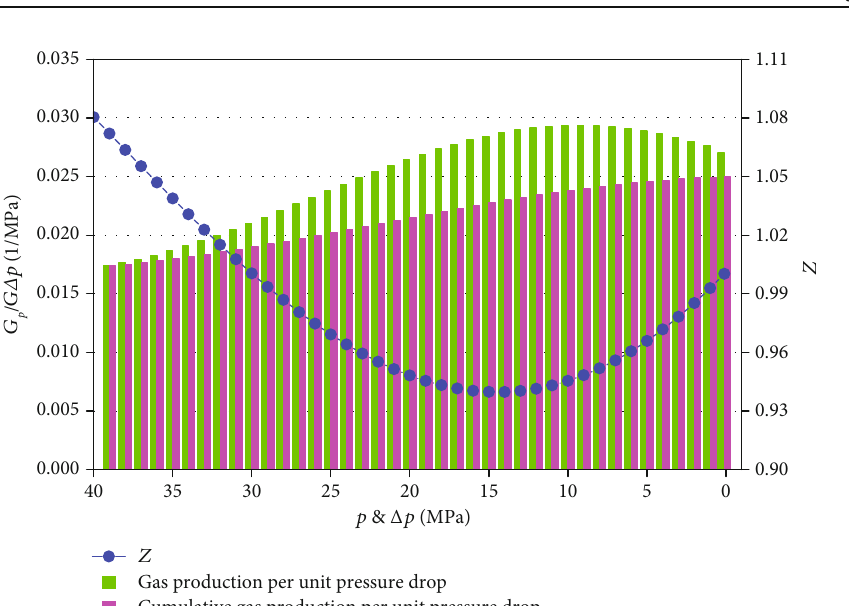
Figure 1: Gas production per unit pressure drop and dimensionless gas production of cumulative unit pressure drop (formation pressure is 40MPa, formation temperature is 373.15K, and gravity of gas is